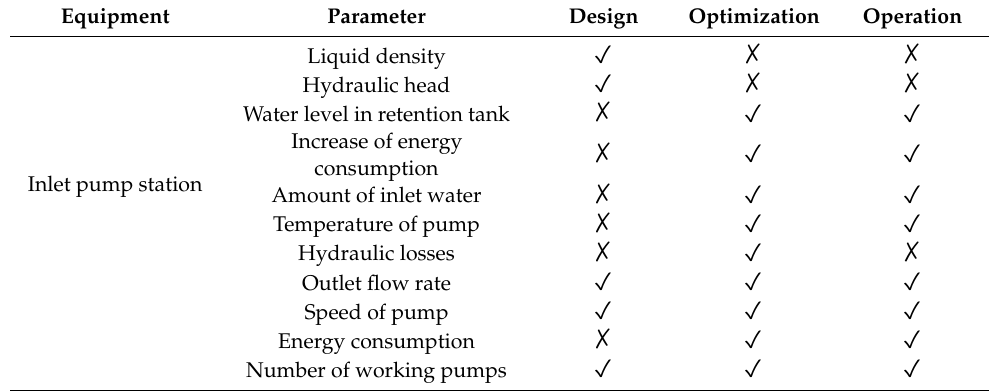
Table 1. Parameters of the inlet pump station.